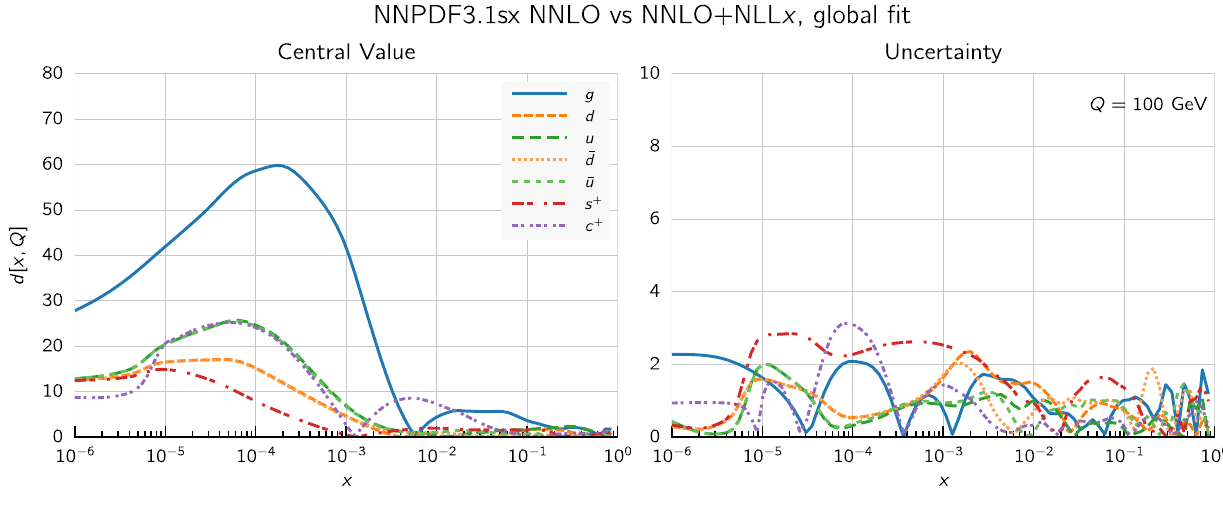
the observed differences are consistent with statistical fluc-